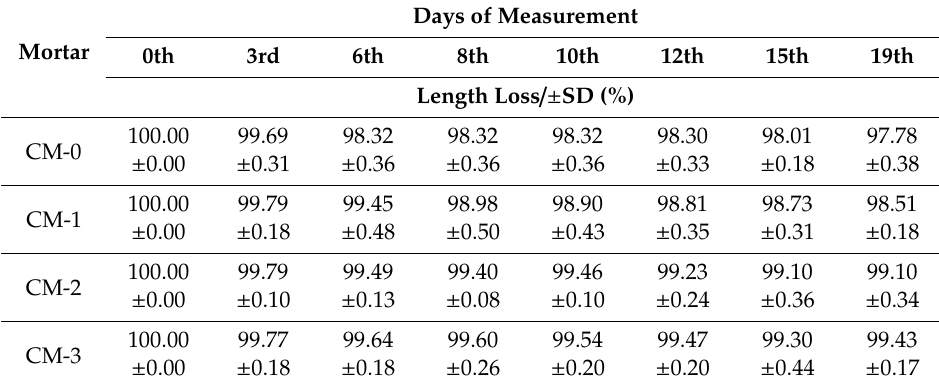
Figure 5. Glauconite clay mortar samples after 1 min of the water immersion. From the left: CM-1, CM-2, CM-3, CM-0.